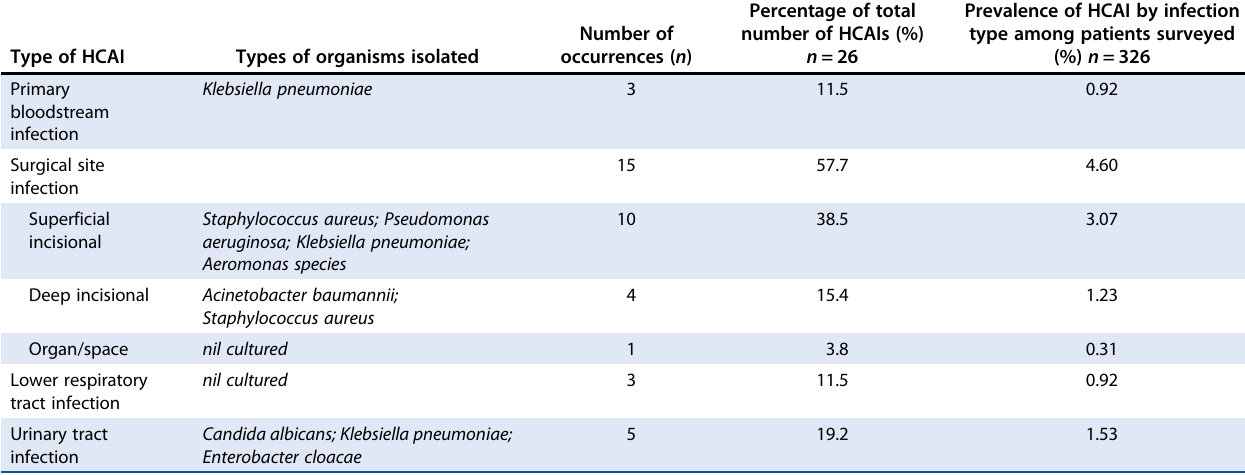
Table 2: Prevalence rates according to the type of healthcare-associated infections ( n = 26)